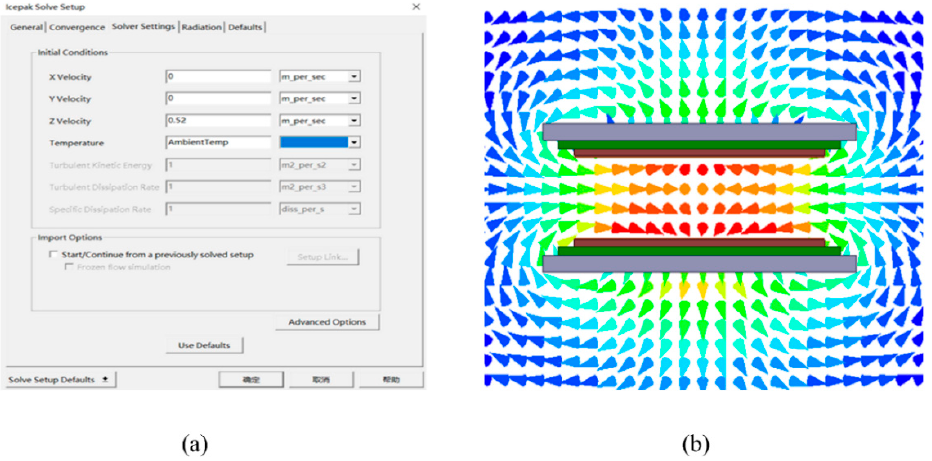
Figure 13. Speed setting diagram ( a ) Speed setting chart ( b ) Speed effect